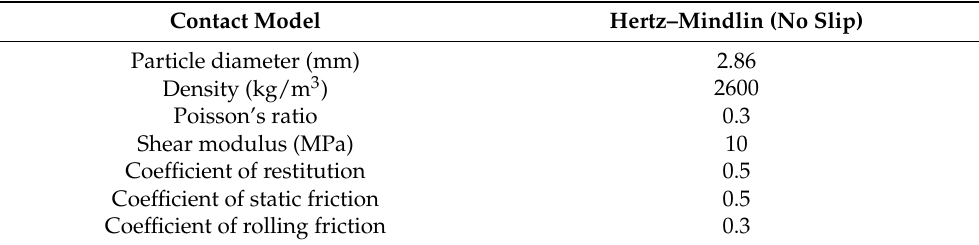
Table 1. Contact parameters for sandy soil with a repose angle of 30.43 ◦ .